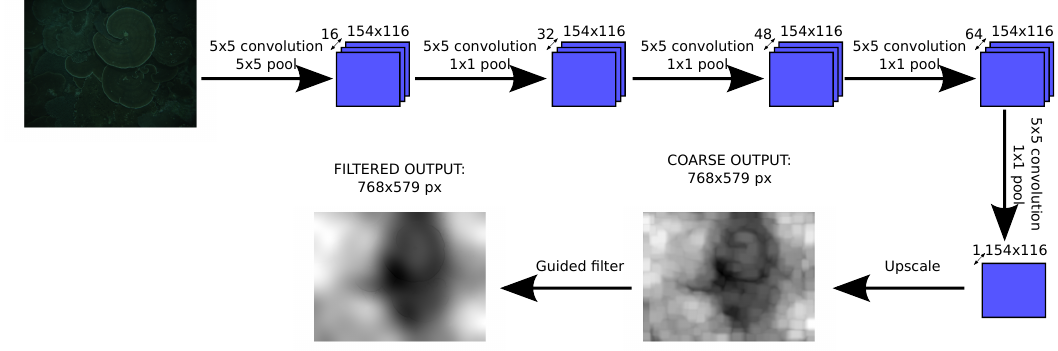
Figure 1. Architecture of the convolutional network used to estimate